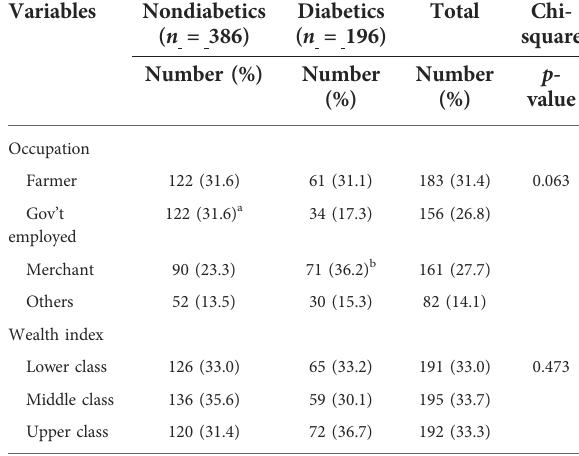
TABLE 1 Sociodemographic and clinical characteristics of study participants attending the outpatient department in Bichena Primary Hospital (BPH) in northwest Ethiopia, 2019 ( n